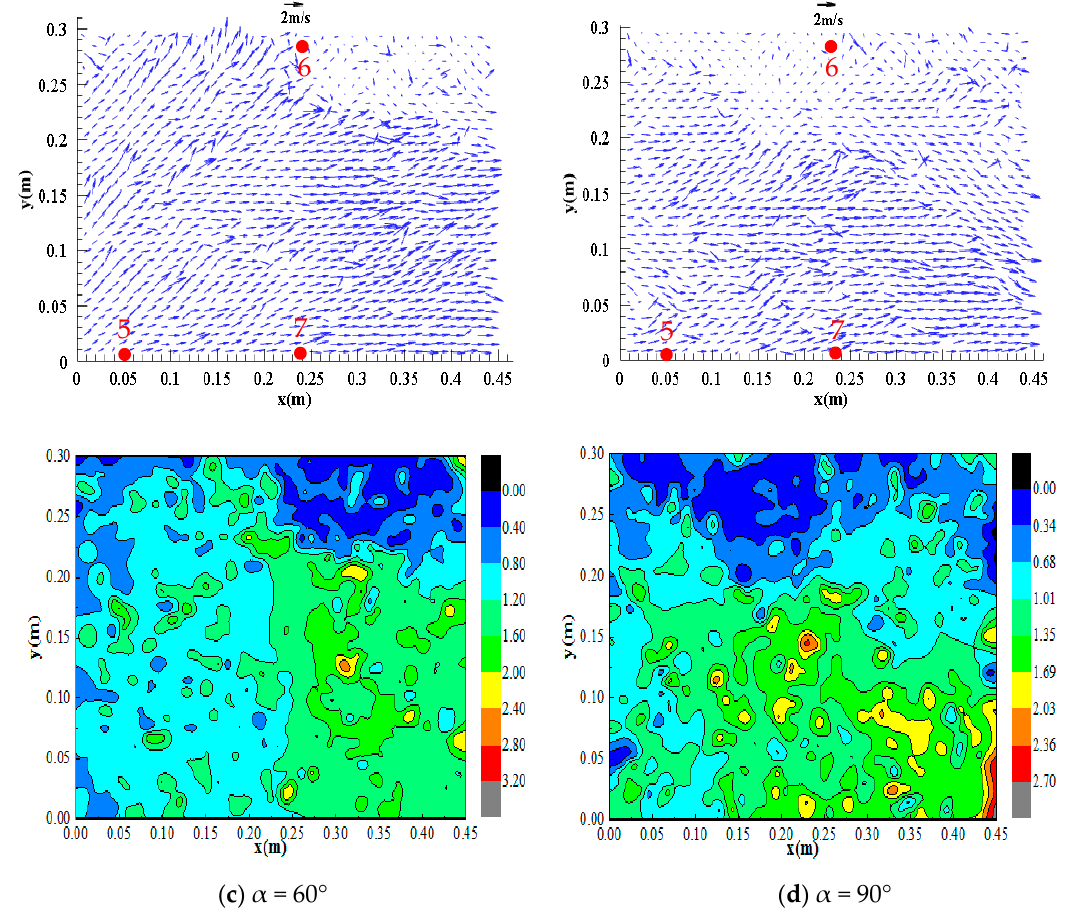
Figure 16. Distributions of the surface flow field of zone 2 under different configurations, ( a ) α = 30°; ( b ) α = 45°; ( c ) α = 60°; ( d ) α = 90°.